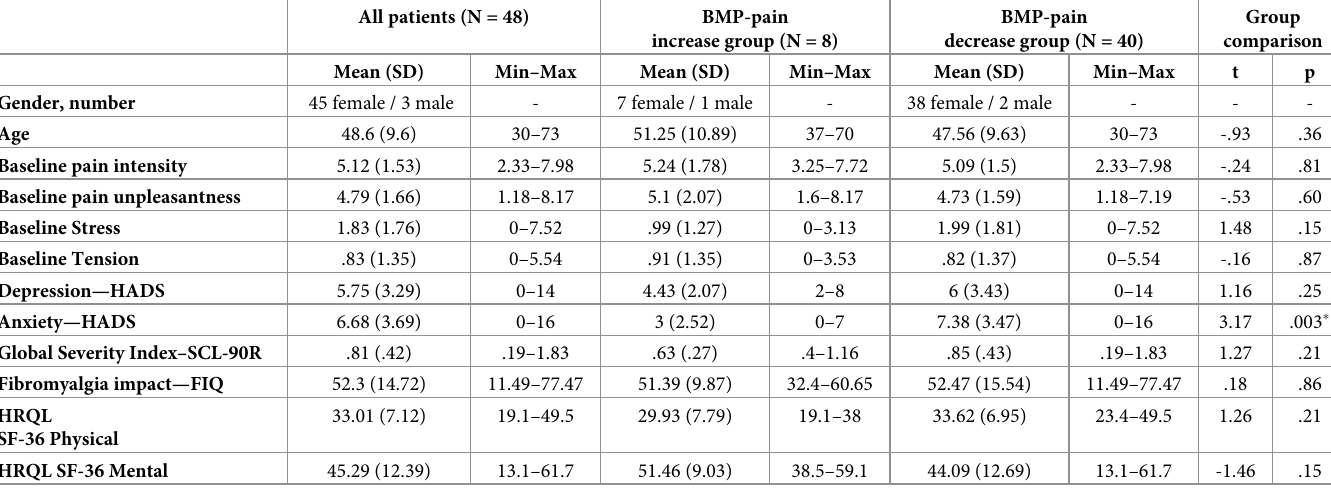
Table 1. Descriptive statistics and group-comparison at baseline.